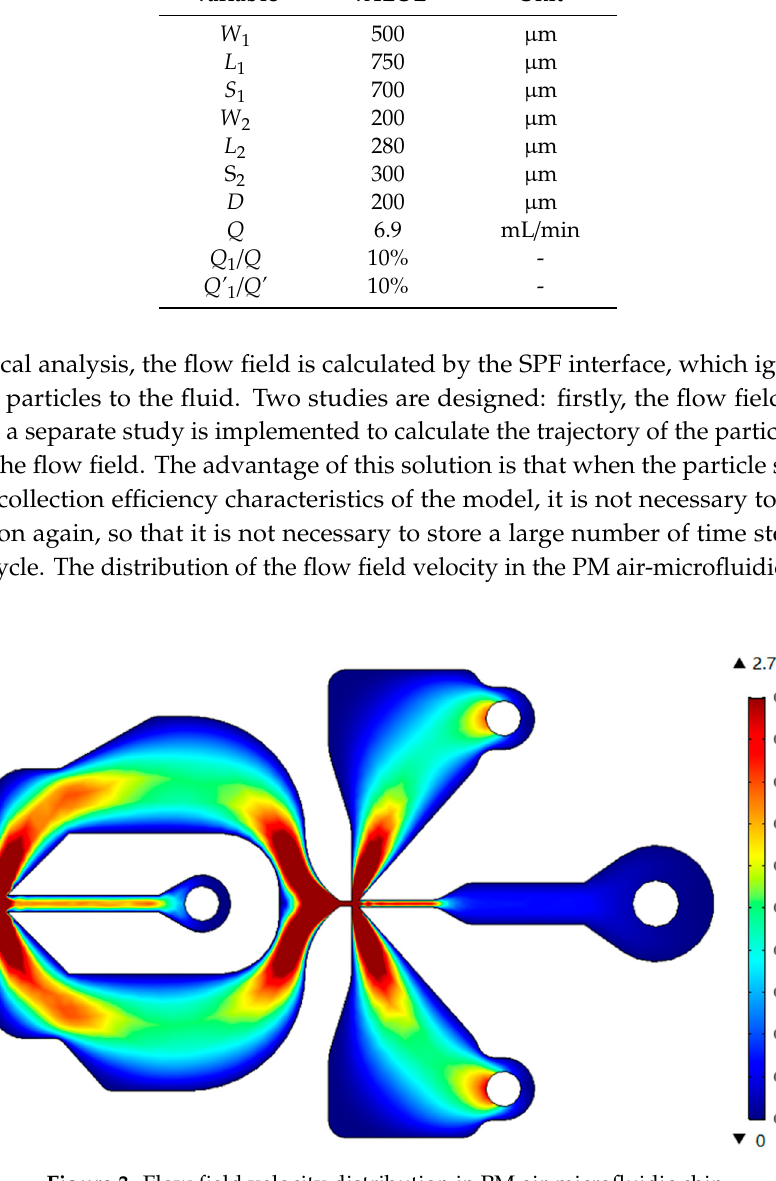
Figure 3. Flow field velocity distribution in PM air-microfluidic chip.